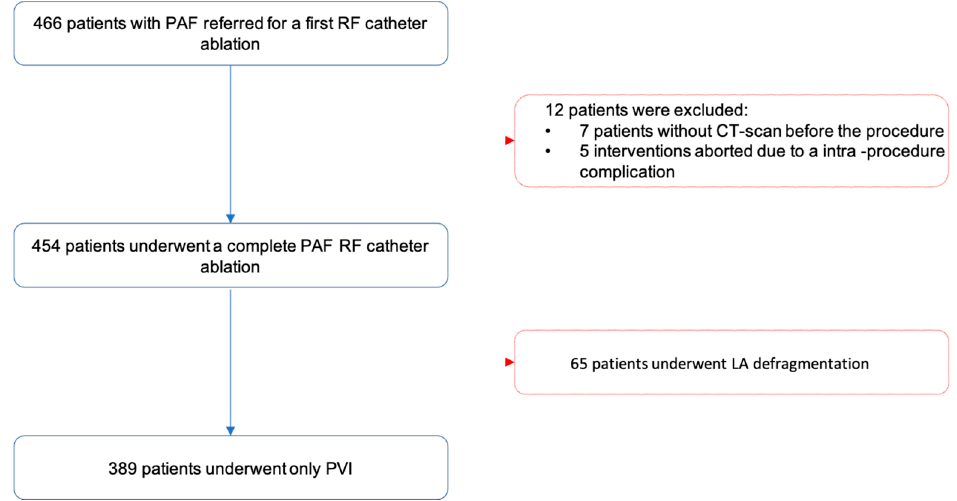
Figure 1. Flowchart for inclusion of patients in the study.